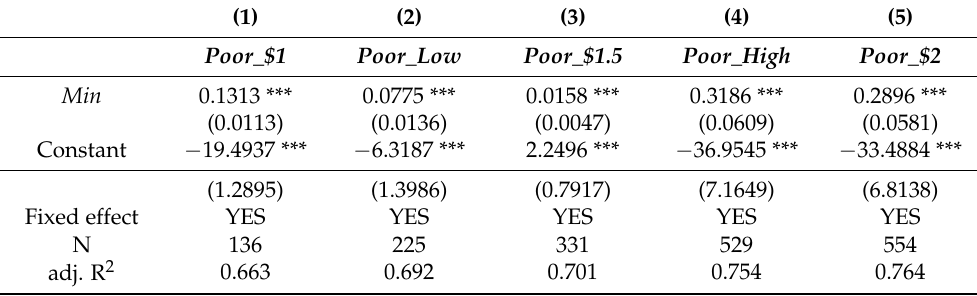
Table 9. Effect of extreme low temperature on groups with a probability of poverty greater than 0.29.